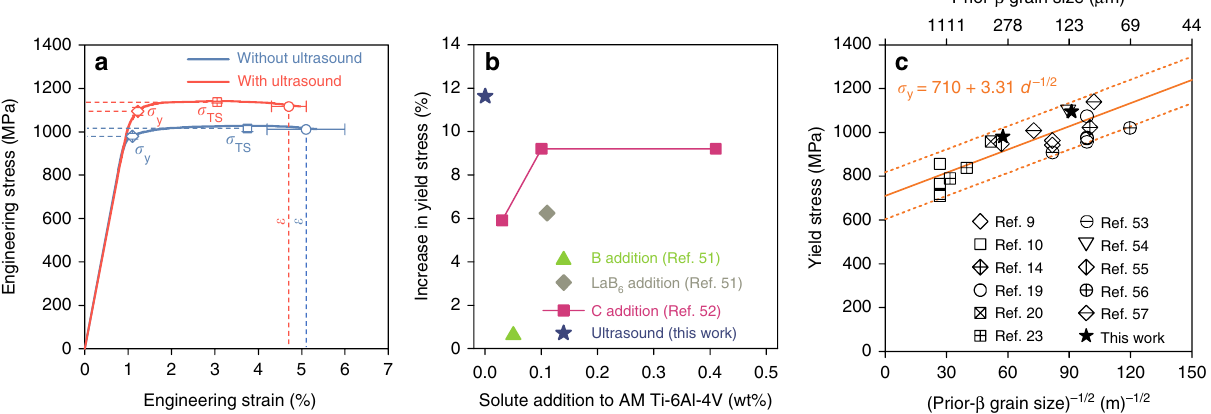
Fig. 5 Tensile properties of AM-fabricated Ti-6Al-4V. a Engineering stress – strain curves of the as-built samples without and with ultrasound (all curves are shown in Supplementary Fig. 3). The error bars represent one standard deviation of three tests. b Change in yield stress of AM-fabricated Ti-6Al-4V by chemical addition 51,52 compared to ultrasound in this work. See Supplementary Table 3 for data and references. c Tensile yield stress with the inverse of square root of prior- β grain size from the literature 9,10,14,19,20,23,53 – 57 and this work. See Supplementary Table 4 for data and references. The solid line in c represents the Hall-Petch line ( σ y = σ 0 + kd − 1/2 , σ 0 : friction stress; k : material constant; d : grain size) of best fi t while the dashed lines de fi ne ±0.15 σ 0 (where σ 0 = 710 MPa) along the linear fi t.